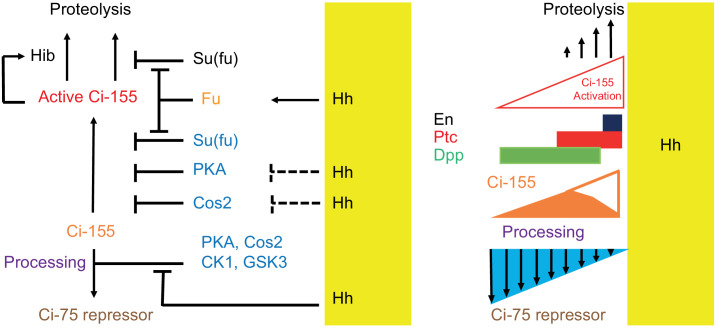
Summary of graded processing, activation, and proteolysis of Ci-155 and underlying mechanisms at the AP border.At the AP border, Hh (emanating from posterior, mustard yellow, territory) inhibits Ci-155 processing stimulated by Cos2, PKA, CK1, and GSK3, and activates Fu protein kinase activity to activate Ci-155, overcoming inhibition by Su(fu) and other factors. Hh also promotes a reduction of Ci-155 levels, most likely by promoting full Ci-155 proteolysis through induction of Rdx/Hib or reducing Su(fu) association. Here we used processing-resistant Ci variants to show that PKA and Cos2 (through binding the CORD domain on Ci-155) limit Ci-155 activity in anterior cells (left) and (right) to deduce the spatial profiles of Hh-stimulated Ci-155 reduction (‘proteolysis’, upward arrows) and inhibition of Ci-155 processing (downward arrows, blue triangle) at the AP border that underlie steady-state Ci-155 levels (brown). Graded target gene (En, Ptc, Dpp) activation is normally elicited by a combination of activated Ci-155 and Ci-75 repressor but was still observed when there was no regulation of Ci-155 processing, indicating that Ci-155 activation must be graded. Although graded Hh signaling was observed when Ci-155 processing is not regulated, Ci-75 repressor must be present in anterior cells to prevent ectopic dpp expression and inhibition of processing was shown to be important for activated Fu to induce high levels of ptc expression. Thus, Hh normally elicits graded inhibition of Ci-155 processing and graded activation of full-length Ci-155 but the activation gradient can suffice provided there is some repressor in anterior cells and Ci-155 is substantially spared from processing at the AP border.